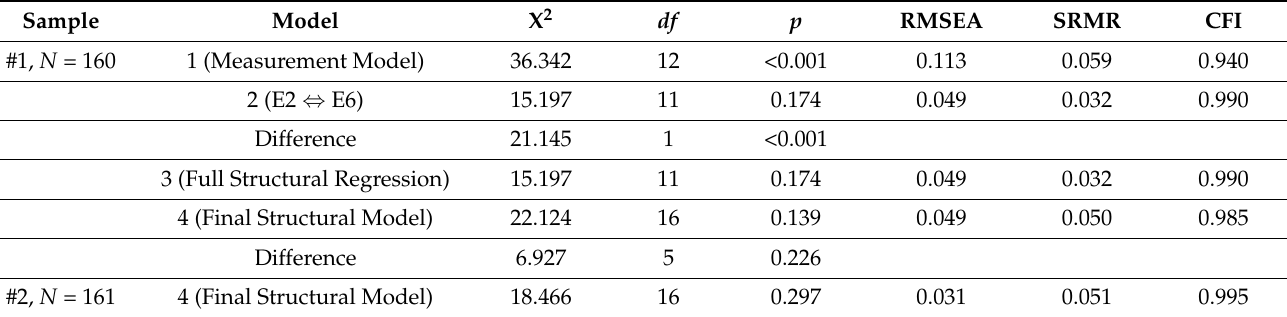
Table 2. (Study 1: Philippines). Fit Indices for Measurement and Structural Regression